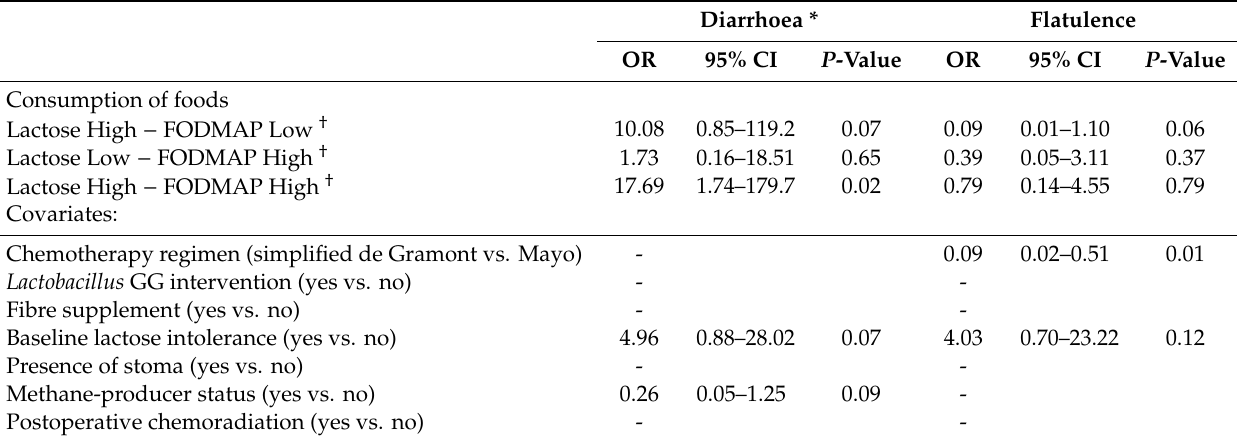
Table 4. Results of multivariate analysis for chemo(radio)therapy-related diarrhoea and flatulence of at least mild intensity (Grade 1–4) during cycles I and III in 52 colorectal cancer